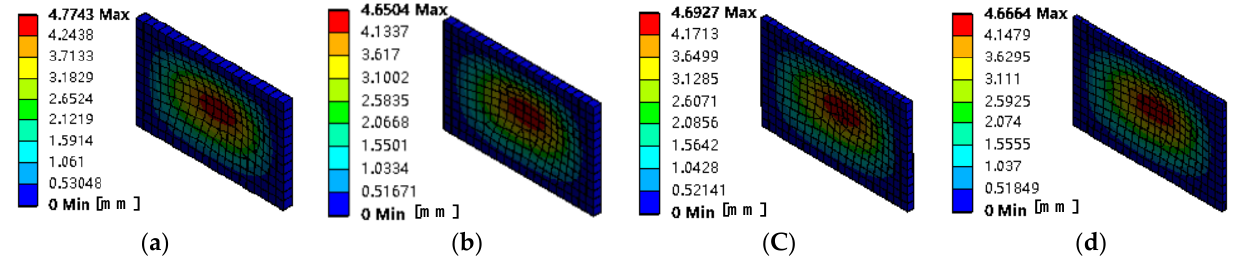
Figure 13. Response diagram of plate with variable edge stiffener width. ( a ) 50 mm wide. ( b ) 40 mm wide. ( c ) 30 mm wide. ( d ) 0 mm wide.